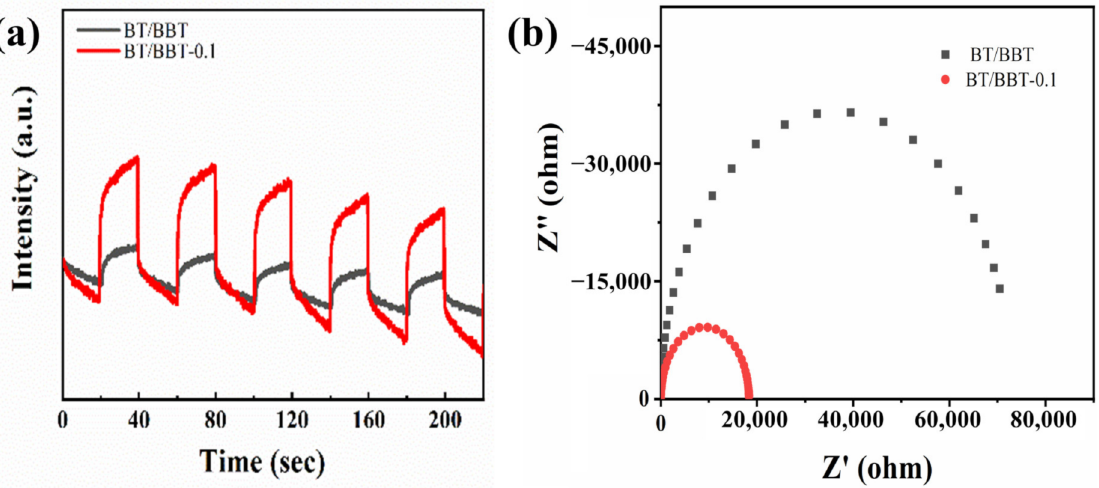
Figure 7. ( a ) Transient photocurrent responses, ( b ) EIS spectra of BT/BBT and BT/BBT-0.1